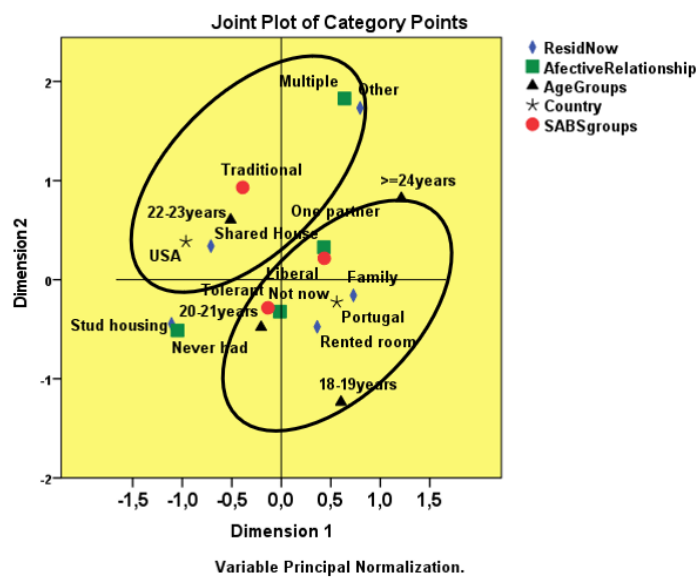
Figure 4. Discriminant measures.